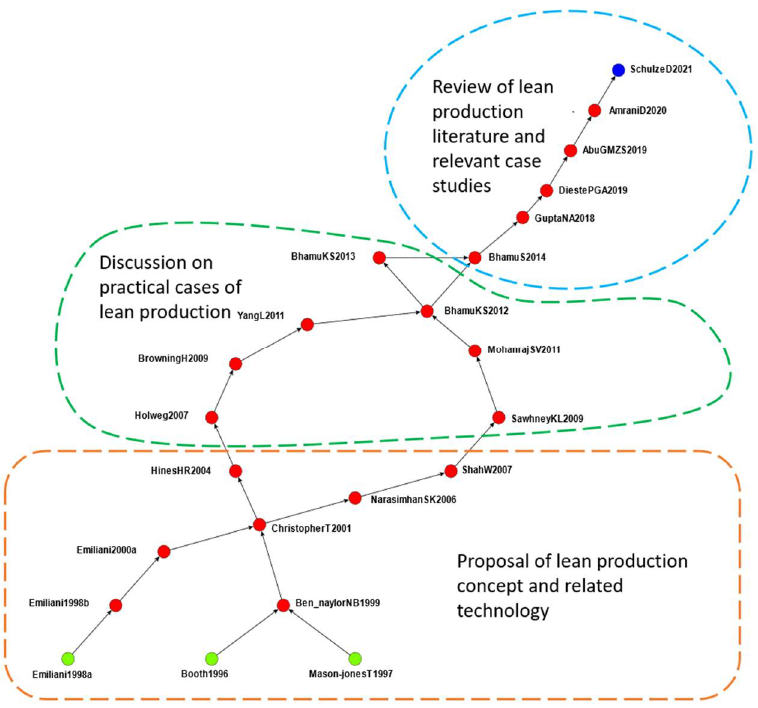
Figure 5. Key-route main